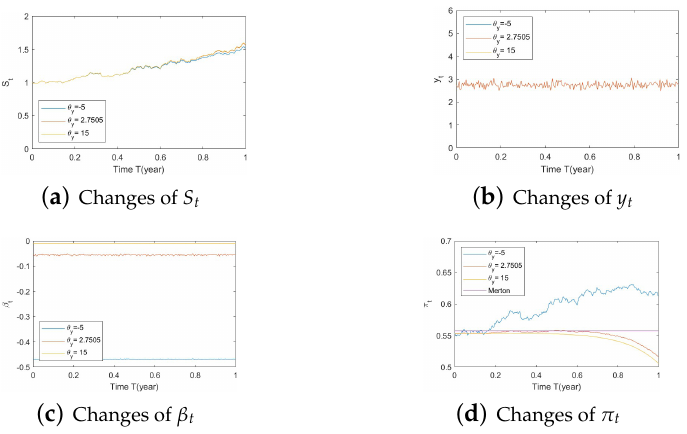
Figure A10. Illustrate the impact on ( a ) stock prices, ( b ) driver of volatility, ( c ) driver of elasticity, ( d ) elasticity of volatility, and ( e ) optimal stock allocations when varying the speed of reversion, κ y ( e . g ., κ y = 125,250,500 ) .